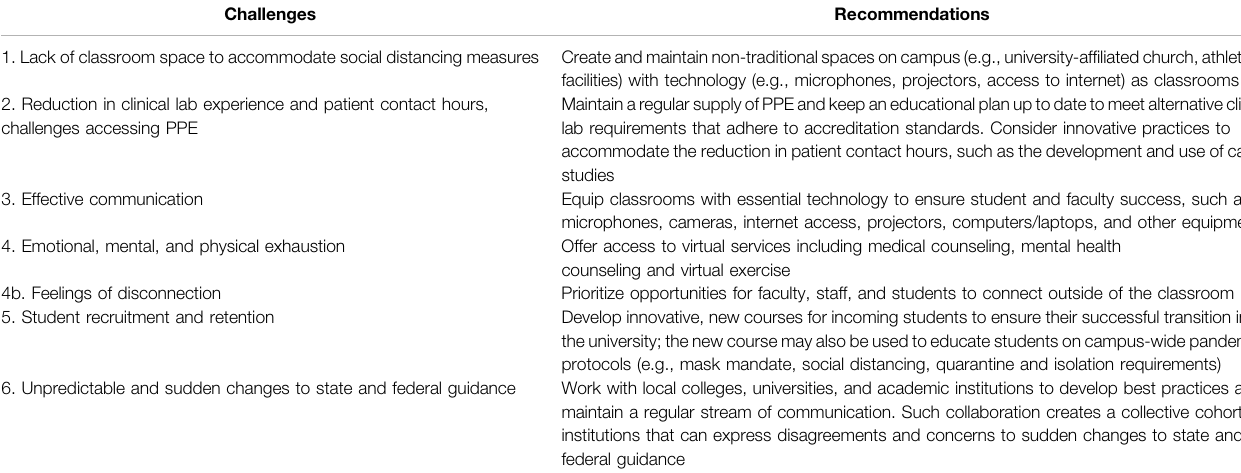
TABLE 2 | Summary of key challenges and recommendations. Challenges